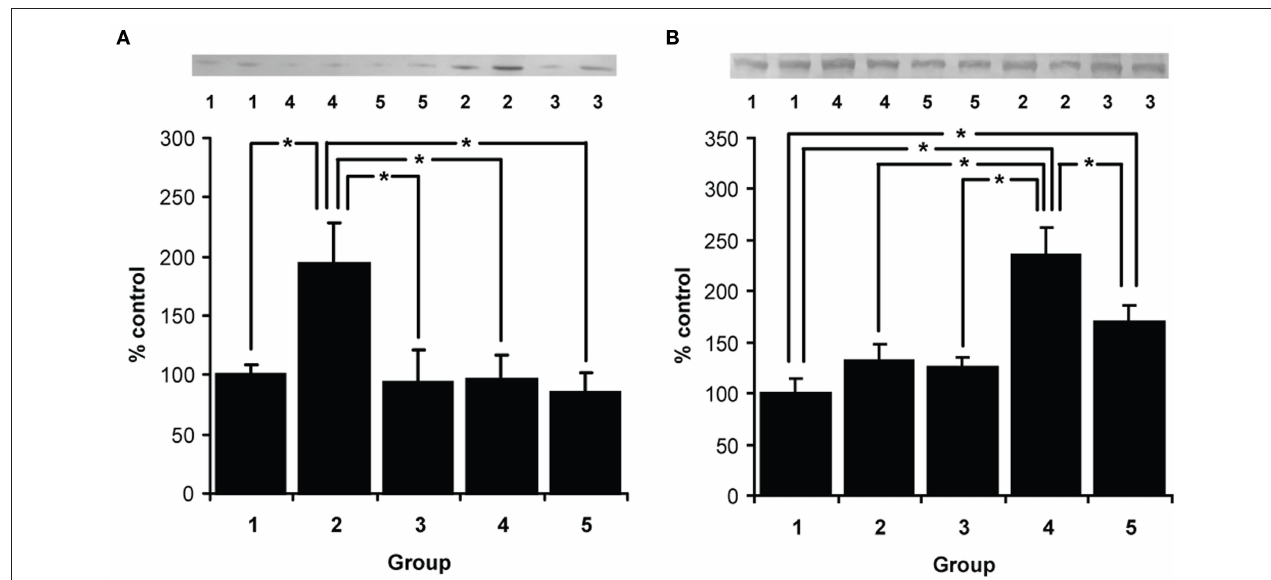
Figure 1 | expression of BDNF (A) and Zif268 (B) proteins. Western blot analysis of dorsal hippocampal protein levels 2 h after final behavioral session